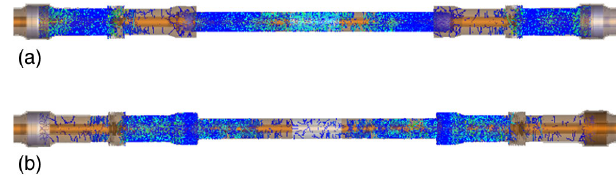
FIG. 14. Multipacting distribution in the fundamental couplers when the left short is at z ¼ − 30 cm (a) and − 76 cm (b), with 2.5 kW of power in the cavity.